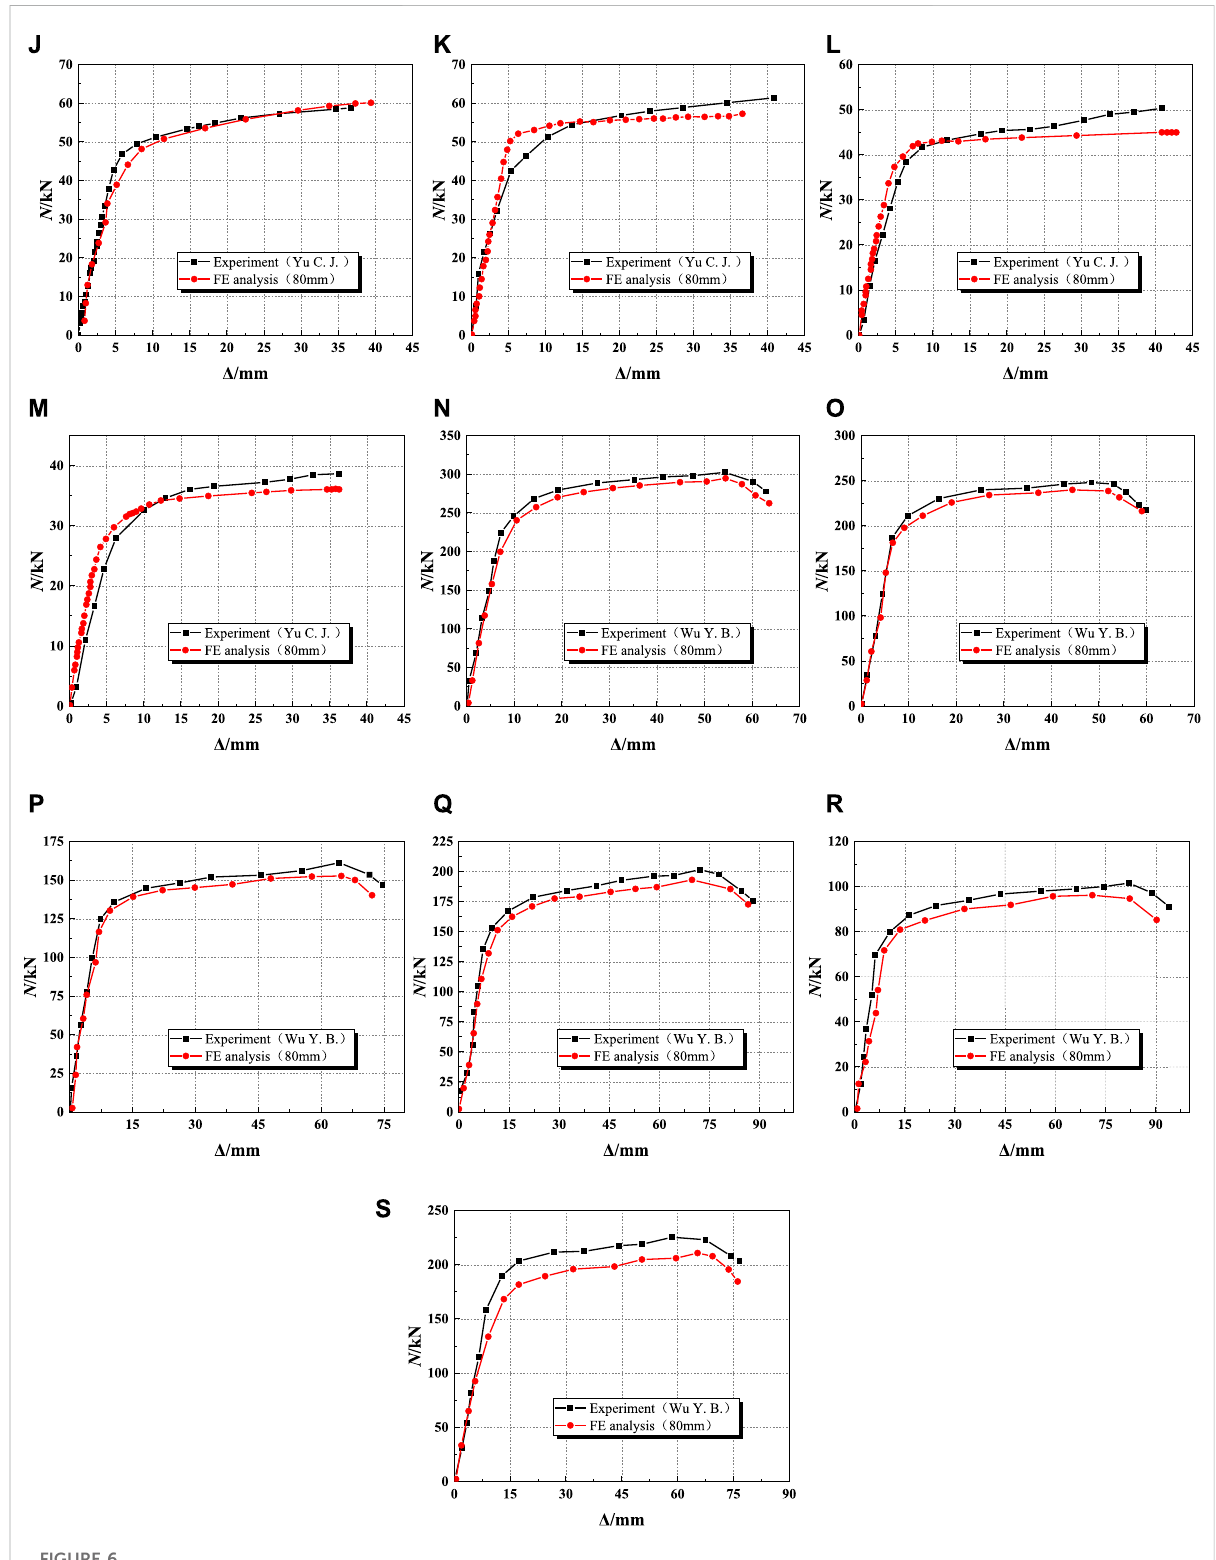
FIGURE 6 Comparisons between simulated curves and experimental curves (A) L1 (B) L2 (C) L3 (D) L4 (E) L5 (F) L6 (G) L7 (H) L8 (I) L9 (J) L10 (K) L11 (L) L12 (M) L13 (N) L14 (O) L15 (P) L16 (Q) L17 (R) L18 (S)